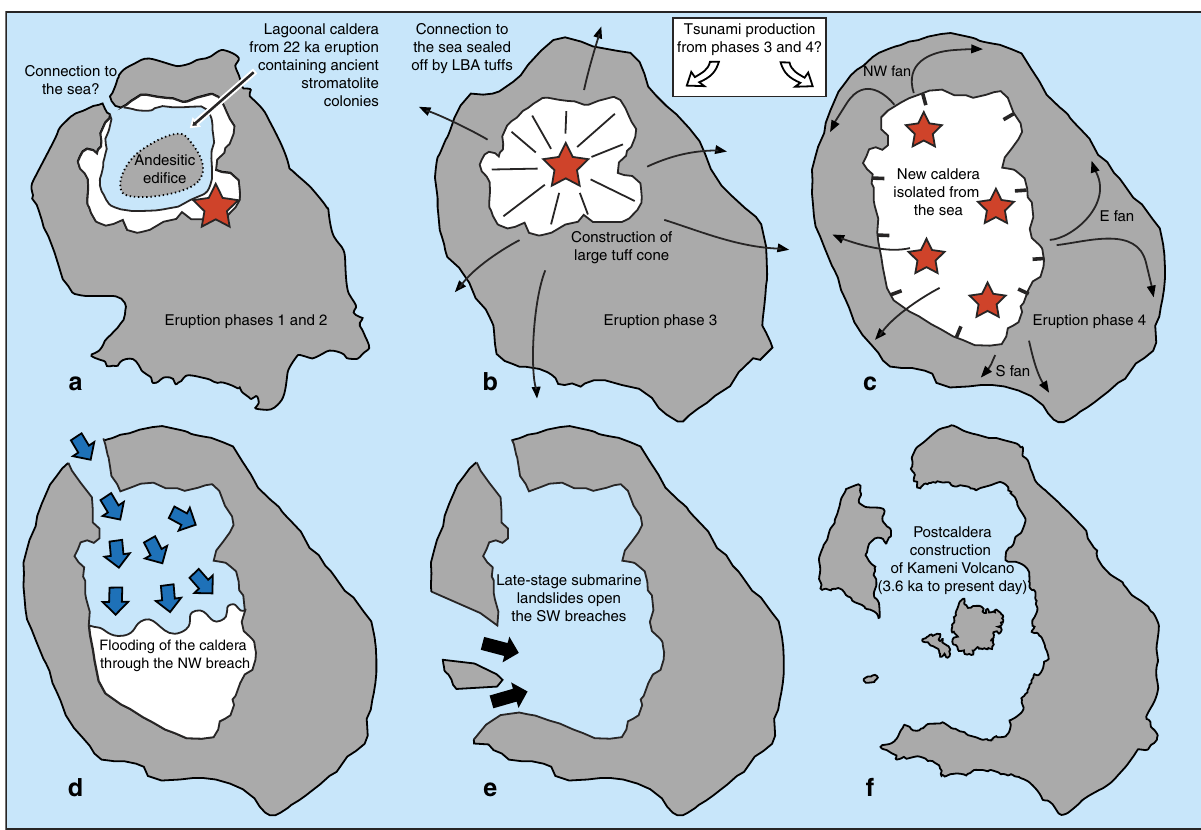
Figure 6 | Summary of the development of Santorini caldera before and during and following the LBA eruption. ( a – c ) Pre-eruptive morphology of the volcano 18–21 and the main phases of the eruption 1–5 . Before the eruption there existed an ancient caldera in the northern half of the volcanic field 18,19 . This caldera was lagoonal, as shown by the presence of fragments of ancient travertine, stromatolites and brackish to marine fauna in the LBA ejecta 20,21 . There was also an andesitic edifice within this caldera 5 . In eruptive phase 1 a Plinian eruption took place, which in phase 2 was joined by the production of syn-plinian pyroclastic surges. In phase 3, eruption of ‘cold’ phreatomagmatic pyroclastic flows constructed a large tuff cone that filled the old caldera, cutting it off from the sea. In phase 4, eruption of hot pyroclastic flows took place from multiple subaerial vents, forming at least three ignimbrite fans (NW, E and S), and associated caldera collapse enlarged and deepened the ancient caldera. The main eruptive vents are shown in these figures as red stars (locations well constrained for phases 1 to 3, but speculative for phase 4). Black arrows show schematic emplacement vectors for the pyroclastic flows of phases 3 and 4. ( d , e ) Post-eruptive opening of the NW and SW straits (based on the present research). At the end of the eruption the caldera was dry and isolated from the sea, probably due to thick accumulations of LBA tuff. The sea first broke through to the NW, where a combination of water erosion and landslip carved out the NW strait and flooded the caldera (blue arrows in d ) in less than a couple of days. Submarine landslides (black arrows in e ) then opened up the SW straits once the caldera was largely flooded. ( f ) The present-day volcanic